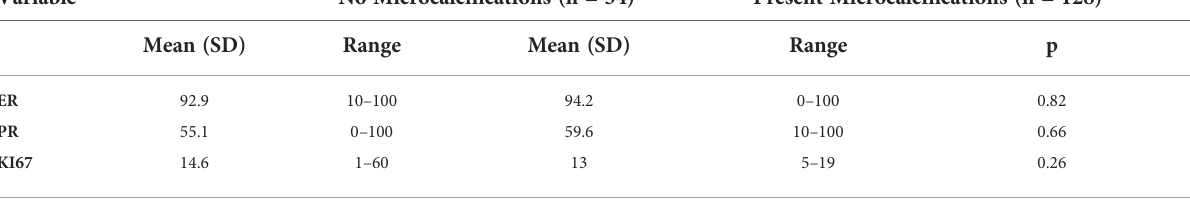
TABLE 3 Comparison between presence of microcalci fi cations and molecular tumor pro fi le. Variable No Microcalci fi cations (n =